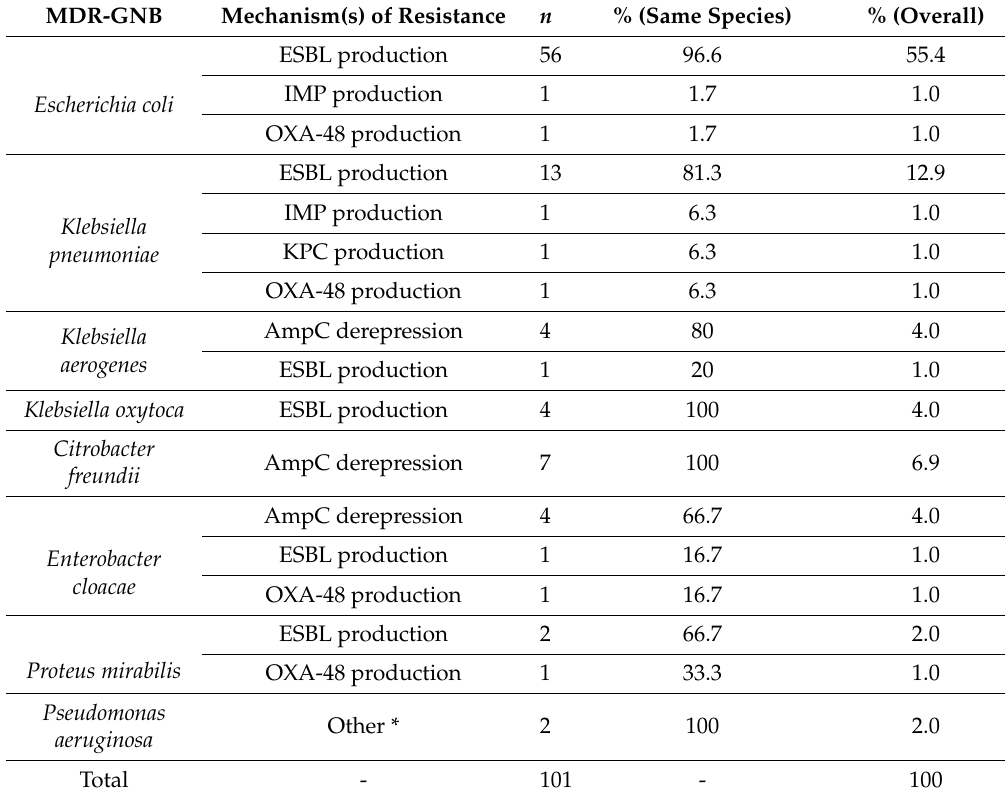
Table 2. MDR-GNB identified in screening upon ICU